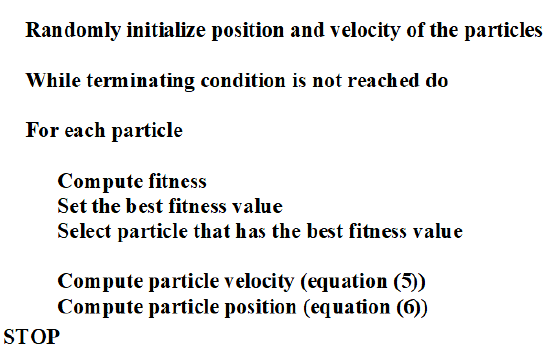
Figure 5. Pseudocode of particle swarm optimization algorithm.